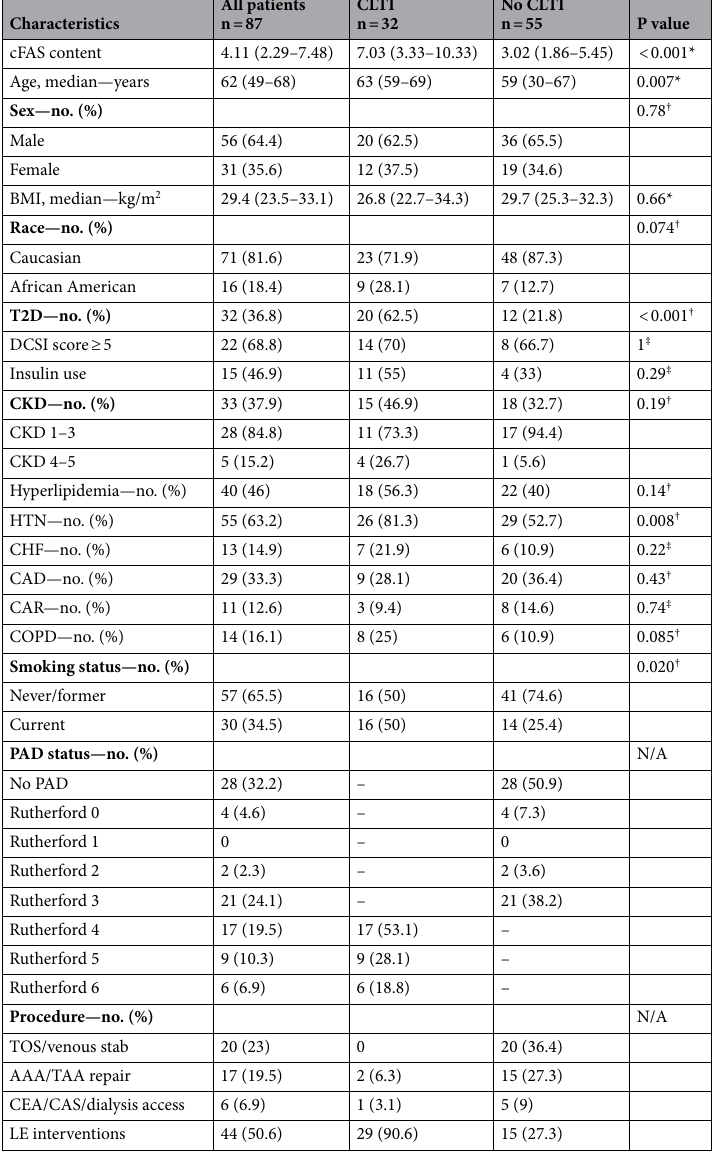
Table 1. Baseline characteristics of patients who underwent analysis for serum FAS content. AAA: abdominal aortic aneurysm; BMI: body mass index; CAR: carotid artery stenosis; CAS: carotid artery stenting; CEA: carotid endarterectomy; cFAS: serum circulating fatty acid synthase; CHF: congestive heart failure; CKD: chronic kidney disease; CLTI: chronic limb-threatening ischemia; COPD: chronic obstructive pulmonary disease; Current smoker: last smoked within 12 months of vascular procedure; DCSI: diabetes complications severity index; Former smoker: last smoked > 12 months before procedure; HTN: hypertension; LE interventions: lower extremity interventions included endovascular or open procedures and amputation; PAD: peripheral artery disease; T2D: type 2 diabetes mellitus; TAA: thoracic aortic aneurysm; TOS: thoracic